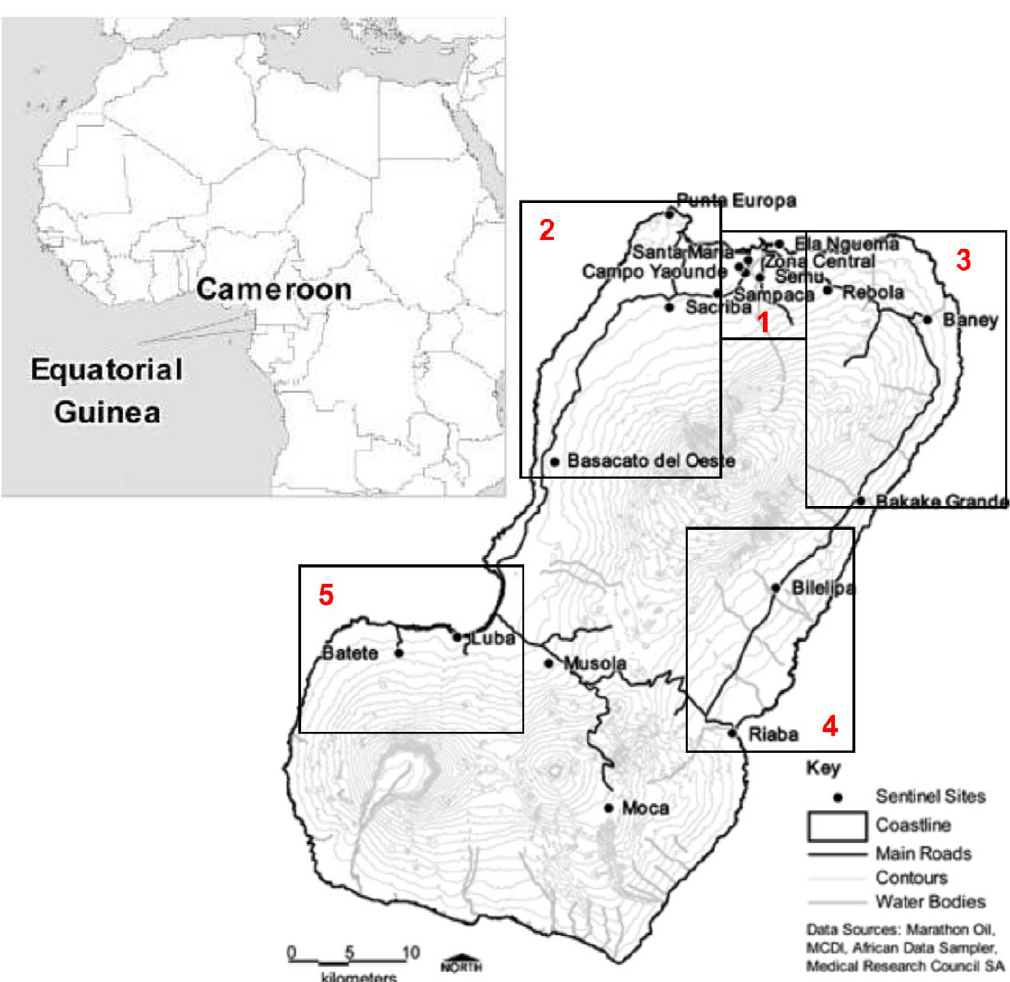
Figure 1. Location of the 18 sentinel sites used for monitoring and evaluation of the BIMCP. Source: Kleinschmidt et al (2007) [17]. Regions are highlighted in boxes. 1- Malabo 2- North West 3- North East 4- South East and 5-South